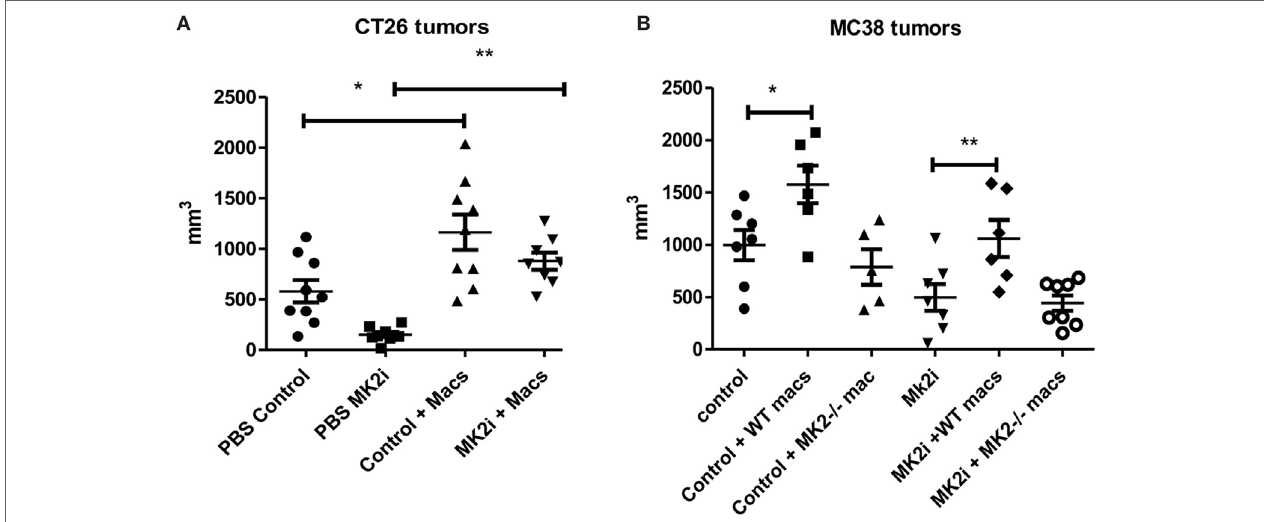
FigUre 6 | The MK2 pathway in macrophages is critical for CT26 and MC38 tumor growth. Mouse tumors grown from (a) CT26 cells were decreased in volume with MK2 inhibitor treatment, but increased with 10 6 wild-type bone marrow-derived macrophage injection and (B) MC38 tumors were decreased in volume with MK2 inhibitor treatment, increased with additional wild-type macrophages, but not with MK2 − / − macrophage injection. All tumors were excised and measured at day 13. N = 7–8, * and ** p ≤ 0.05.